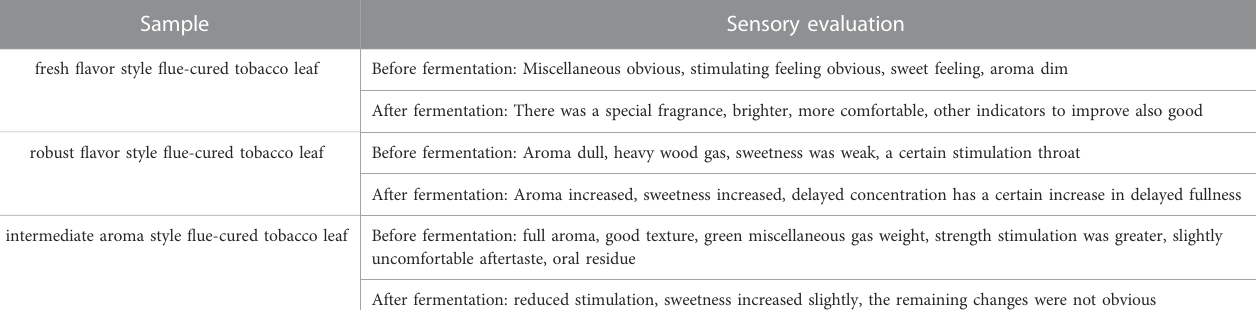
TABLE 5 Sensory evaluation results of strain F7# on low-grade tobacco leaves. Sample Sensory